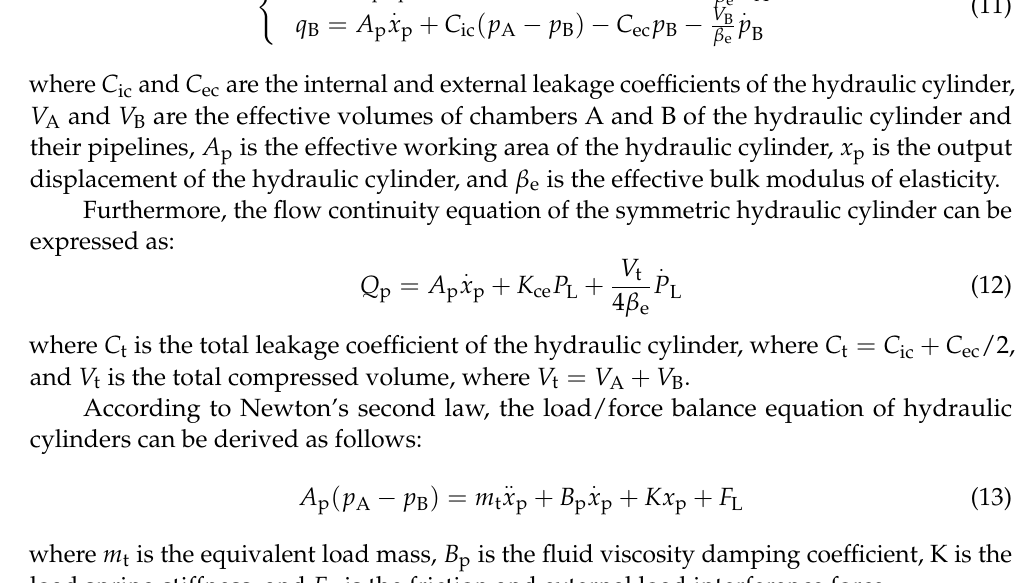
Figure 4. Flow distribution of the hydraulic cylinder.